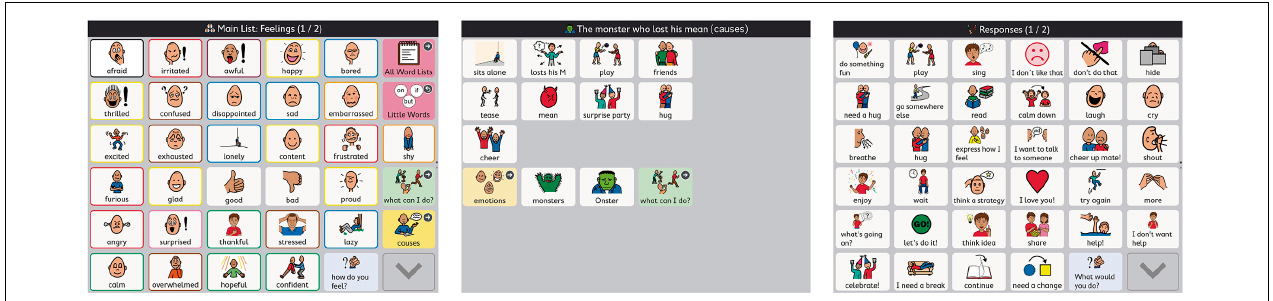
FIGURE 1 | Example of emotion communication dynamic display page [emotions, causes, and responses to emotions]. The Picture Communication Symbol R (cid:13) and Boardmaker by Tobii Dynavox R (cid:13) All Rights Reserved. Used with permission.